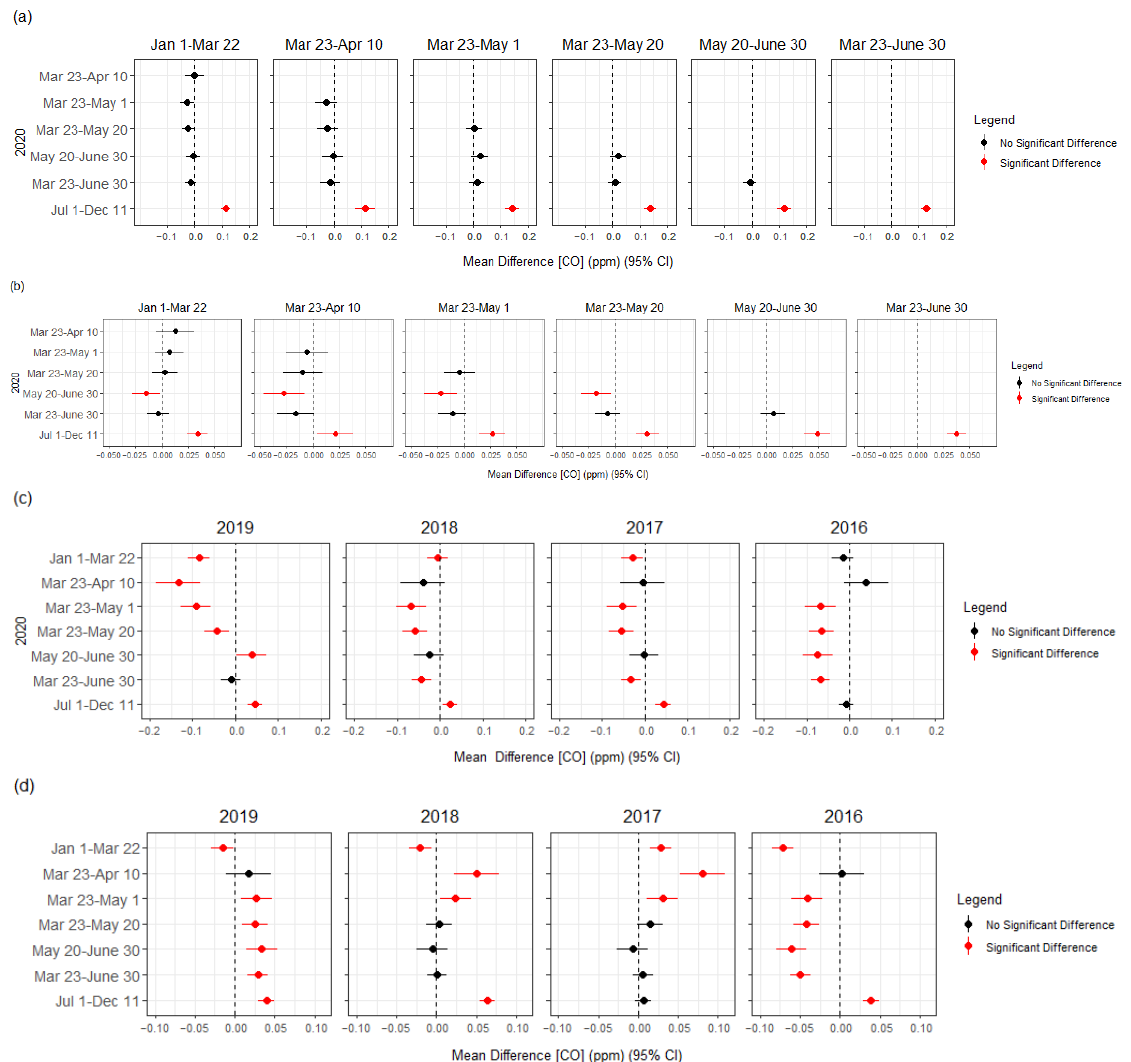
Figure 16. Post hoc test results for intra-annual and interannual CO concentration comparisons at the Near Road and Taft sites: ( a ) intra-annual at Near Road; ( b ) intra-annual at Taft; ( c ) interannual at Near Road; ( d ) interannual at Taft. The circles represent the difference in mean hourly CO concentration between the two time periods on each axis along with the 95% confidence interval (e.g., top left of top figure: (mean CO 23 March–10 April) − (mean CO 1 January–22 March) = 0.000255 ppm).